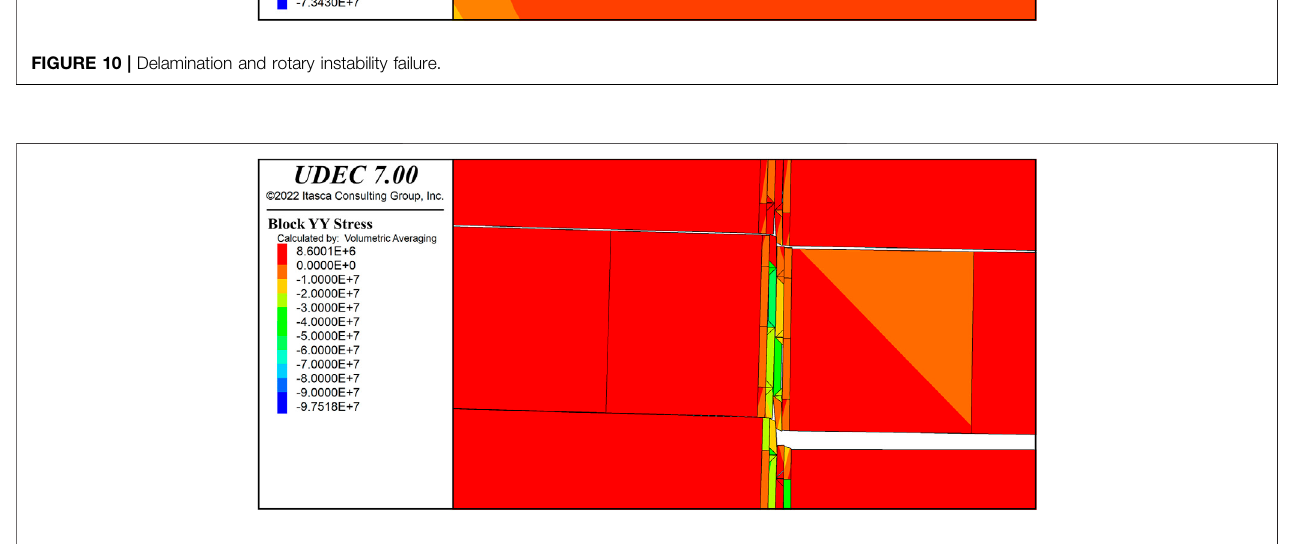
FIGURE 11 | Blasting borehole damage.